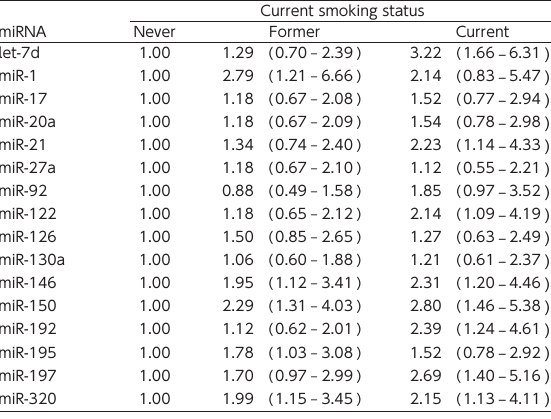
Odds ratios and 95% confidence intervals were adjusted for age, sex, BMI, SBP, HbA1c, serum total cholesterol levels, eGFR and current drinking status.